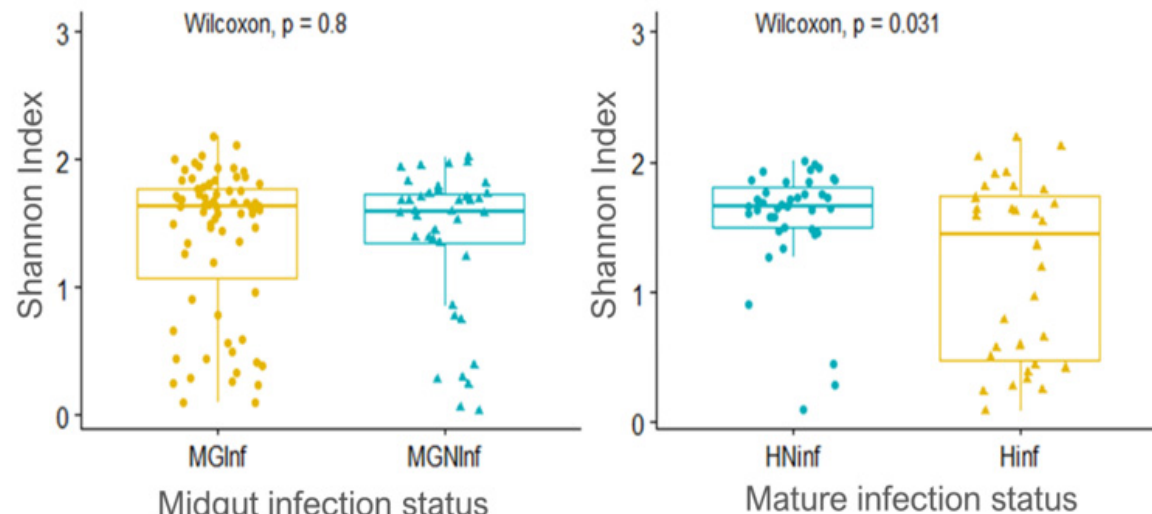
Figure 8. Tsetse microbiome alpha diversity regarding trypanosome infection status (MGInf: midgut infected; MGNInf: midgut non-infected; HNinf: head non-infected; Hinf: Head infected).